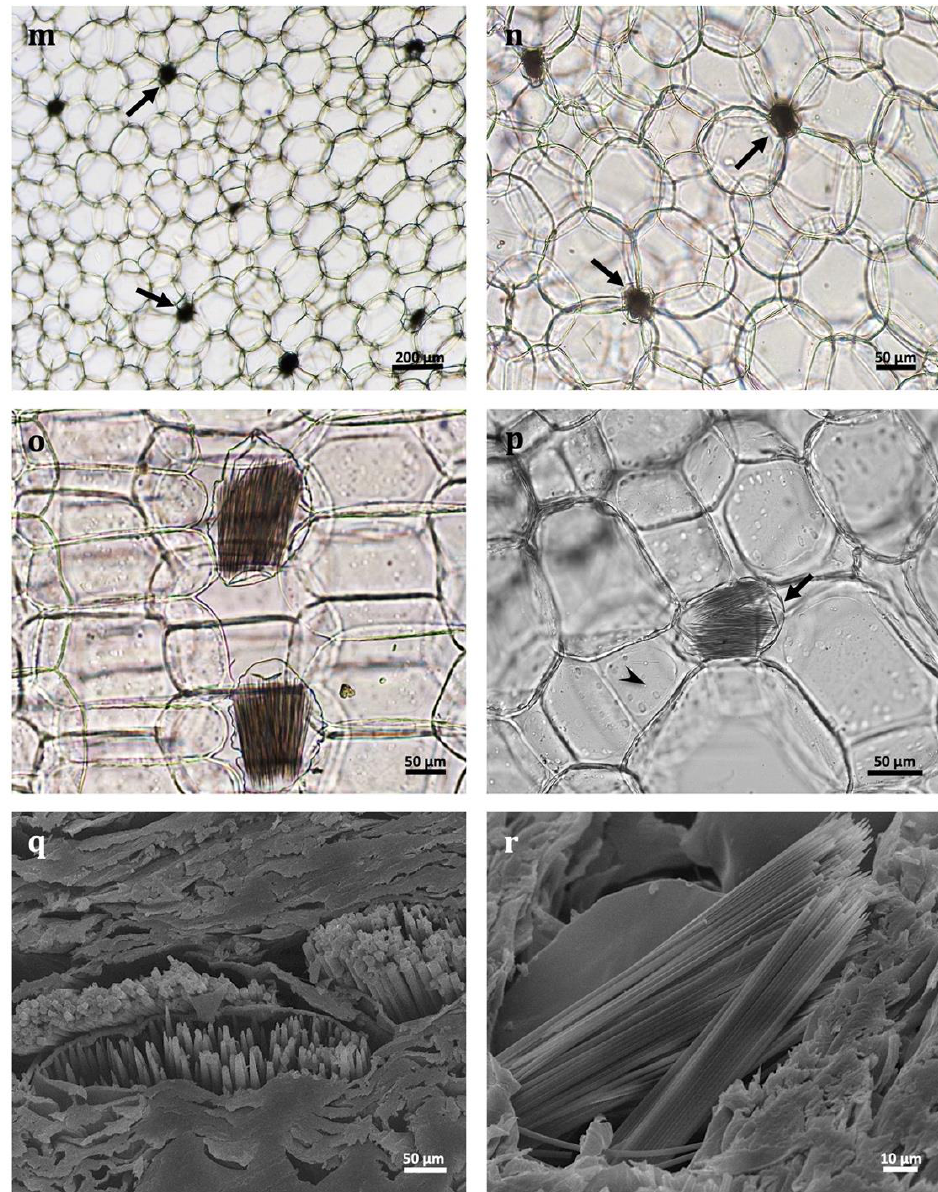
Figure 2. Microscopic features of Portuguese Asphodelus species. LM ( a , b , e , f , g , h ) and SEM ( c , d ) images of velamen with multiple layers (E — epidermis, EX — exodermis cells with suberized walls, CP — cortical parenchyma cells) in A. macrocarpus ( a , c ) and A. bento-rainhae ( b , d ) together with root hairs. Details of cortical parenchyma cells (CP), endodermis (EN), Casparian bands (CB) and vascular cylinder (PE — pericycle; PX — protoxylem; MX — metaxylem; PH — phloem; P — pith cells) in A. macrocarpus ( c , e , g ) and A. bento-rainhae ( d , f , h ) in transversal view. LM ( i , j ) and SEM ( k , l ) images of scalariform vessels with lignified secondary cell wall deposition and fibers in longitudinal view in A. macrocarpus ( i , k ) and A. bento-rainhae ( j , l ). LM ( m – p ) and SEM ( q , r ) images of cortex parenchyma showing thin-walled idioblasts with numerous calcium oxalate crystals, type raphides (arrows) in transversal view ( m , n , q ) and longitudinal view ( o , p , r ) in A. macrocarpus ( m , o , q ) and A. bento-rainhae ( n , p , r ); Details of parenchyma cells with polysaccharides ( p ) such as starch grains (arrowhead). The cortex area (Figure 2e,f, Table 1) between the velamen and central cylinder is up to ± 24 cells wide in A. bento-rainhae and ± 37 in A. macrocarpus , composed of oil cells and thin-walled idioblasts (58.3–62.5 µ m in AbR and 60.7–114.6 µ m in AmR). They